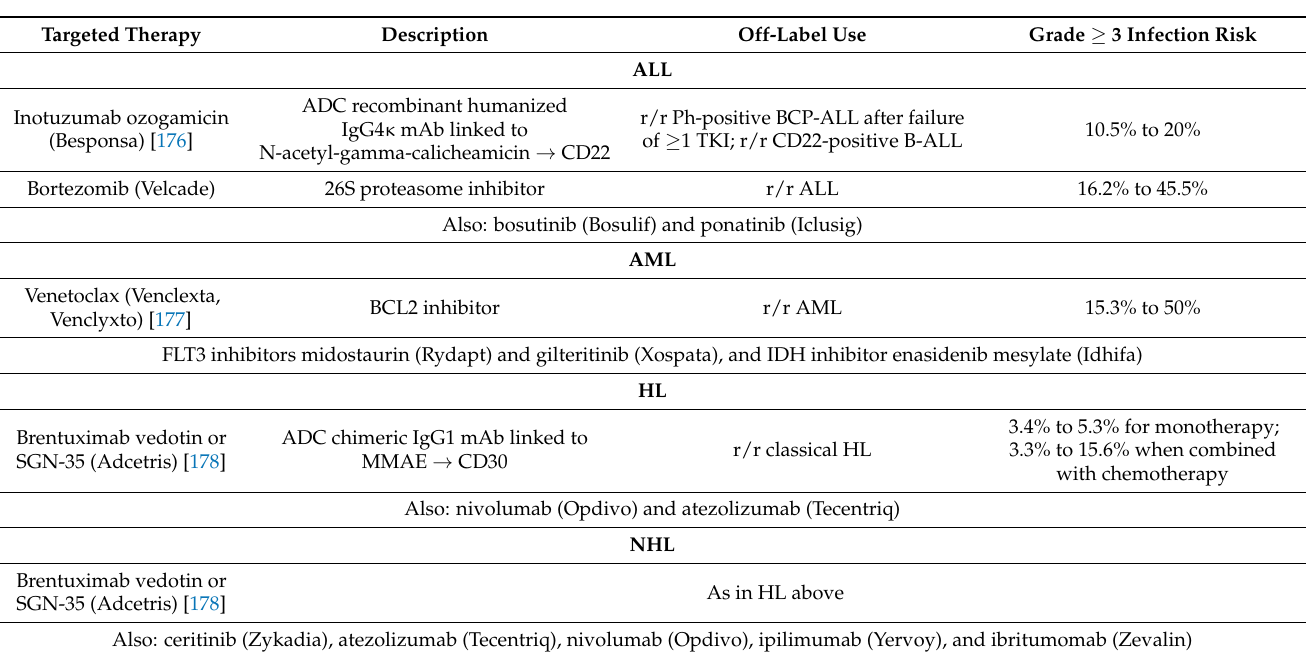
Table 3. Off-label targeted therapies in children with leukemia or